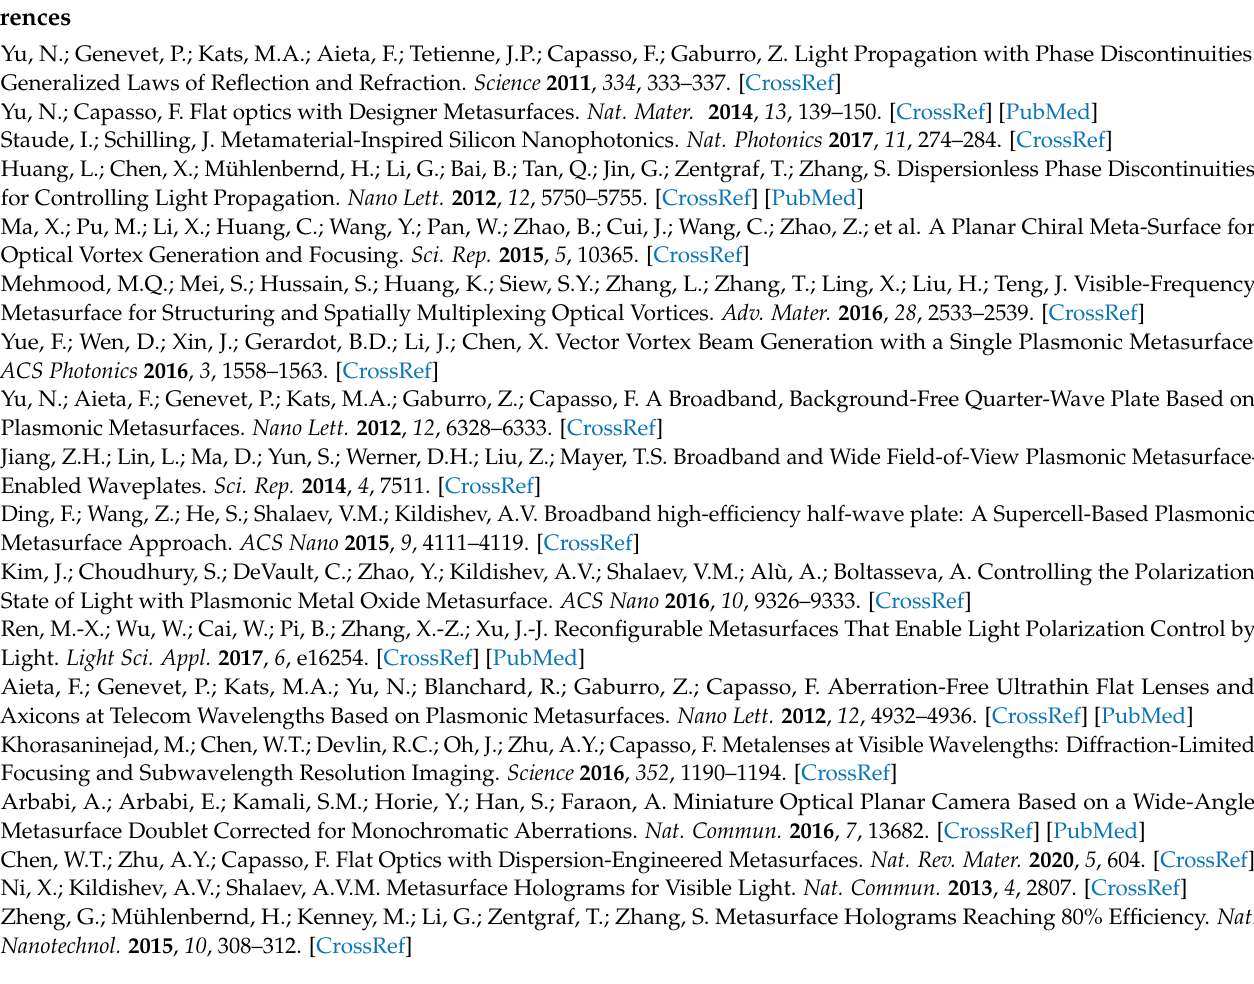
Figure S2: Characterization of a VO 2 based reflectarray metasurface consisting of the 45 ◦ -rotated Au nanorods, Figure S3: Reflection spectra with different thickness of VO 2 film, Figure S4: Dispersions of dielectric constant ( (cid:101) ) with various volume fractions ( f ) of metallic phases of VO 2 , Table S1: The values of volume fraction f and depolarization factor q at different temperature and the parameters of two poles of the Drude–Lorentz model for dielectric constant of VO 2